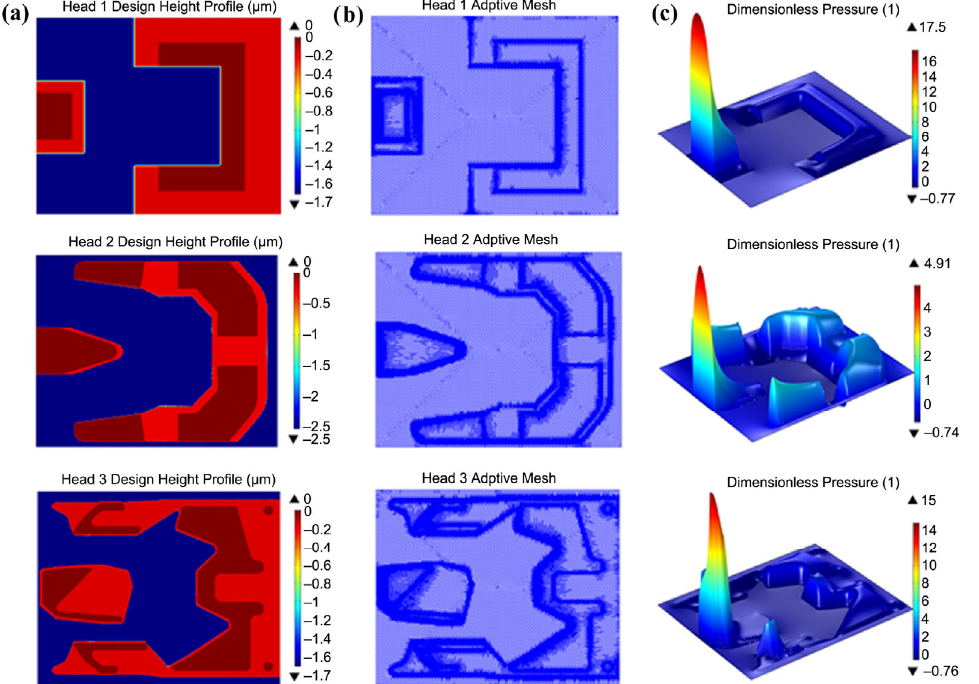
Fig. 3 Three ABS designs: (a) three ABS morphologies with different recess depth, (b) adaptive meshes based on the local pressure gradient, and (c) dimensionless pressure distribution in forward